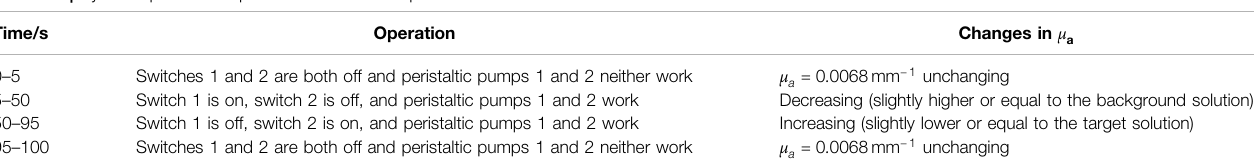
TABLE 2 | Dynamic phantom experiment to mimic the process of breath hold. Time/s Operation Changes in μ